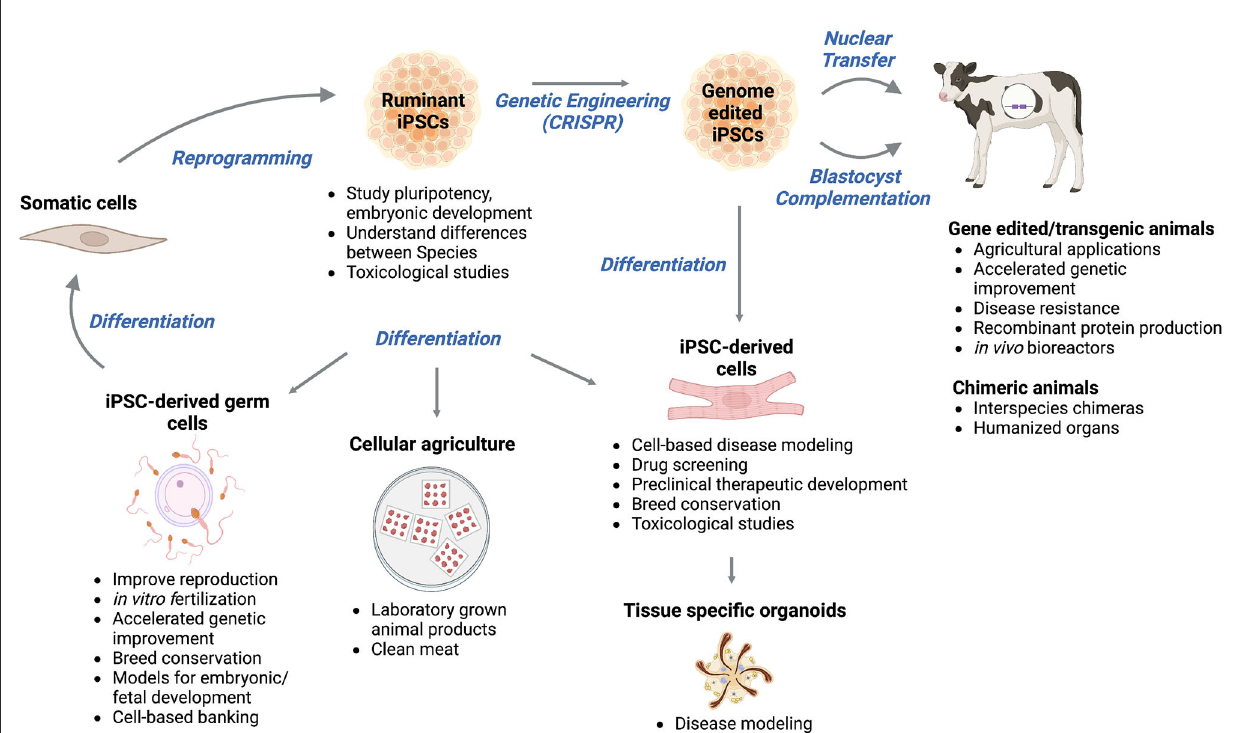
FIGURE1 Applications and future usages of induced pluripotent stem cells (iPSCs) from ruminant livestock. Ruminant iPSCs are generated by the reprogramming of somatic cells. Ruminant iPSCs are a useful tool for studies of pluripotency, embryonic development, and understanding species differences, and can be genetically modified to create transgenic animals for various agricultural, veterinary, biomedical, and pharmaceutical applications. Ruminant iPSCs and/or gene-edited iPSCs have the potential to be used for the generation of interspecies chimeras and humanized organs. They can be the basis for disease modeling, drug screening, preclinical therapeutic development, and toxicological studies. Tissue organoids derived from ruminant iPSCs can be used to model diseases and identify effective treatment options. Ruminant iPSCs can also contribute to cellular agriculture as a source of laboratory-grown animal products. Successful generation of ruminant iPSC-derived germ cells can lead to improved reproduction, genetic improvement, breed conversation, and can be used as tools to study embryonic and/or fetal development. Figure was created using